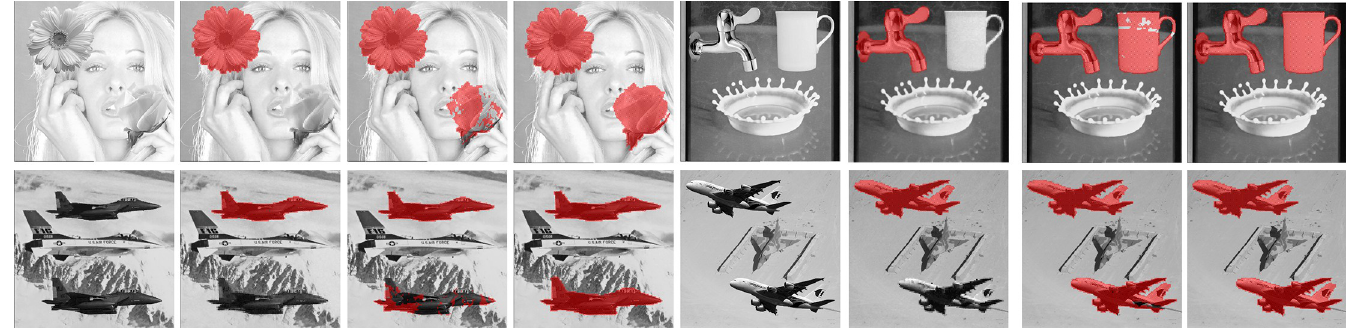
Fig 13. Detection results of [18], [16], [17] and the proposed method for smooth images. (a)-(d) Tiffany image. (e)-(h) Splash image. (i)-(l) Jet image. (m)-(p) Air- plane image.